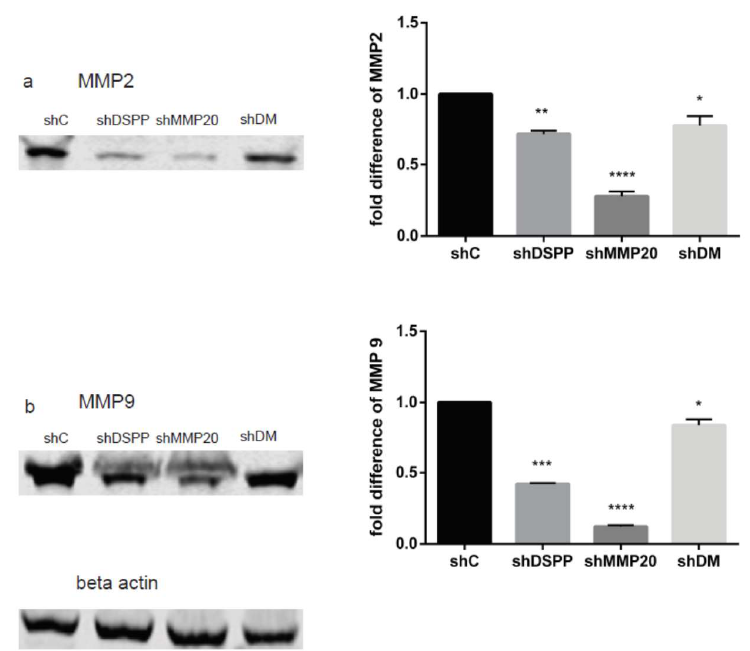
Figure 1. Western blot (WB) analysis of the effect of Dentin Sialophosphoprotein (DSPP) and Matrix Metalloproteinase 20 (MMP20) silencing on MMP2 and MMP9 levels. ( a ) Downregulation of MMP2 in DSPP, MMP20, and combined DSPP was significant (ShDSPP = p < 0.01; shMMP20 = p < 0.001; shDM = p < 0.05) when compared to the control. ( b ) Similarly, downregulation of MMP9 in DSPP,